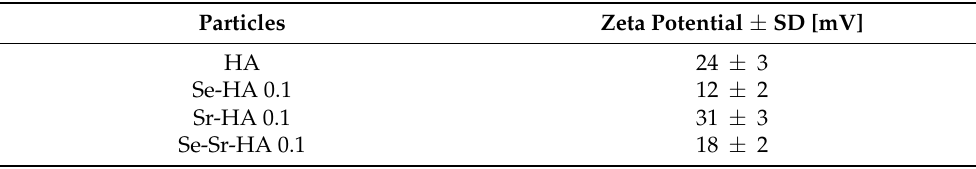
Table 3. Zeta potential measurement for HA, Sr-HA, Se-HA, and Se-Sr-HA nanoparticles in pure